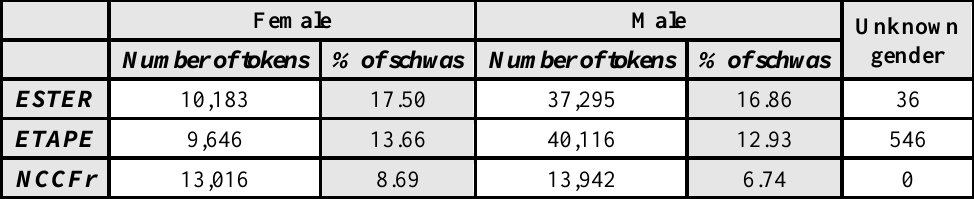
Table 3. Number of tokens by female and male speakers by